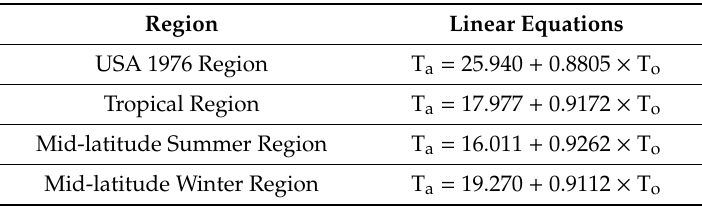
Table 2. The linear equations for the calculation of the e ff ective mean atmospheric temperature (T a ) from the near-surface air temperature (T o )